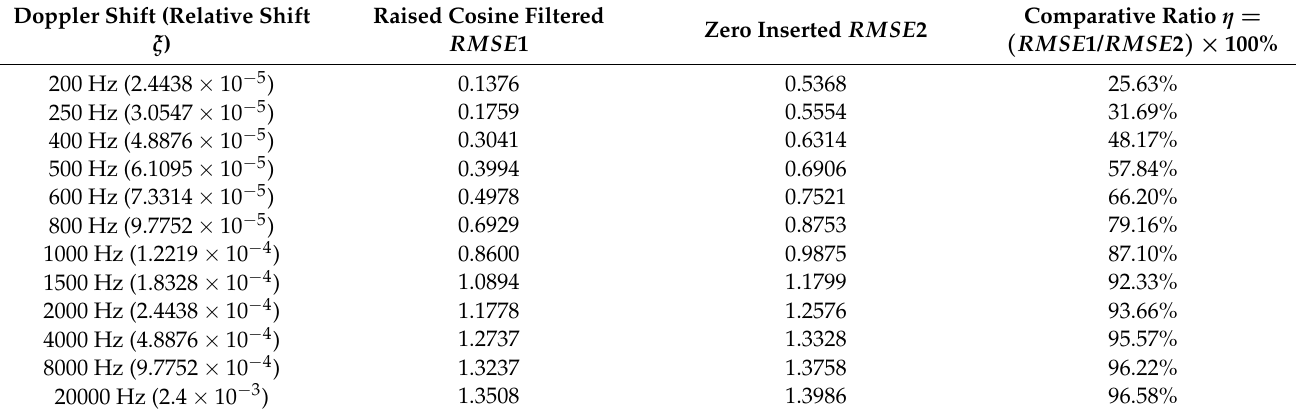
Table 1. RMSEs and comparative ratio under different Doppler